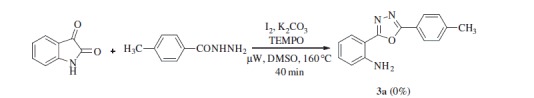
Control experiment using TEMPO.